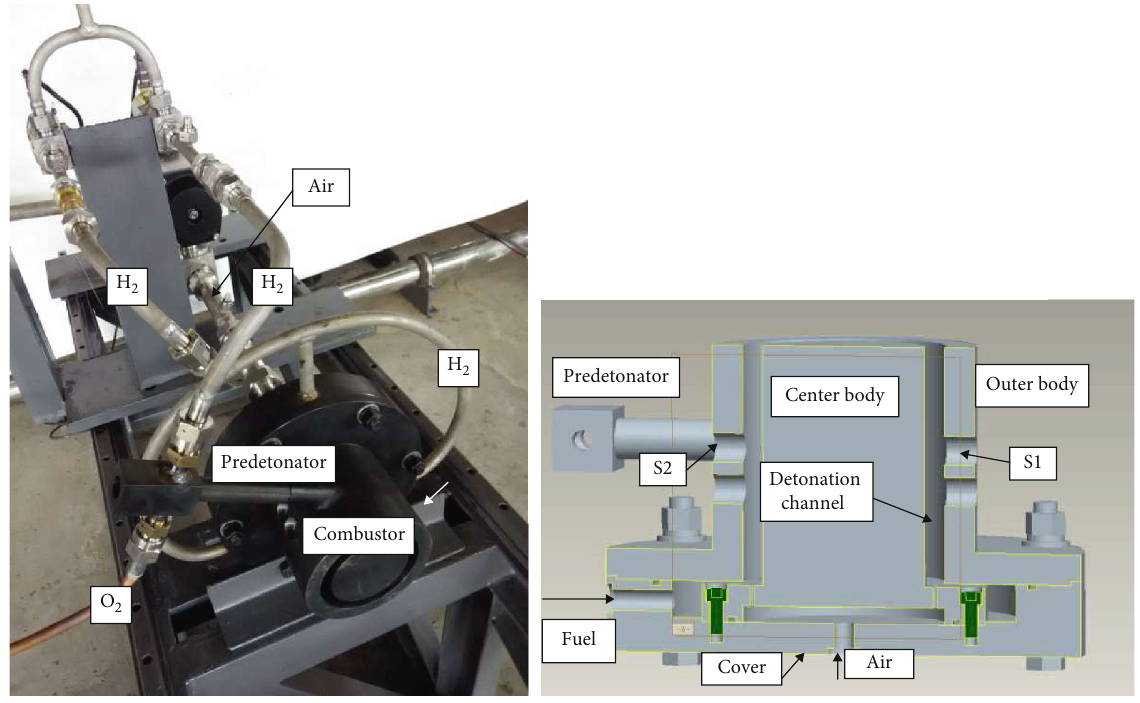
Figure 1: Experimental setup and combustor